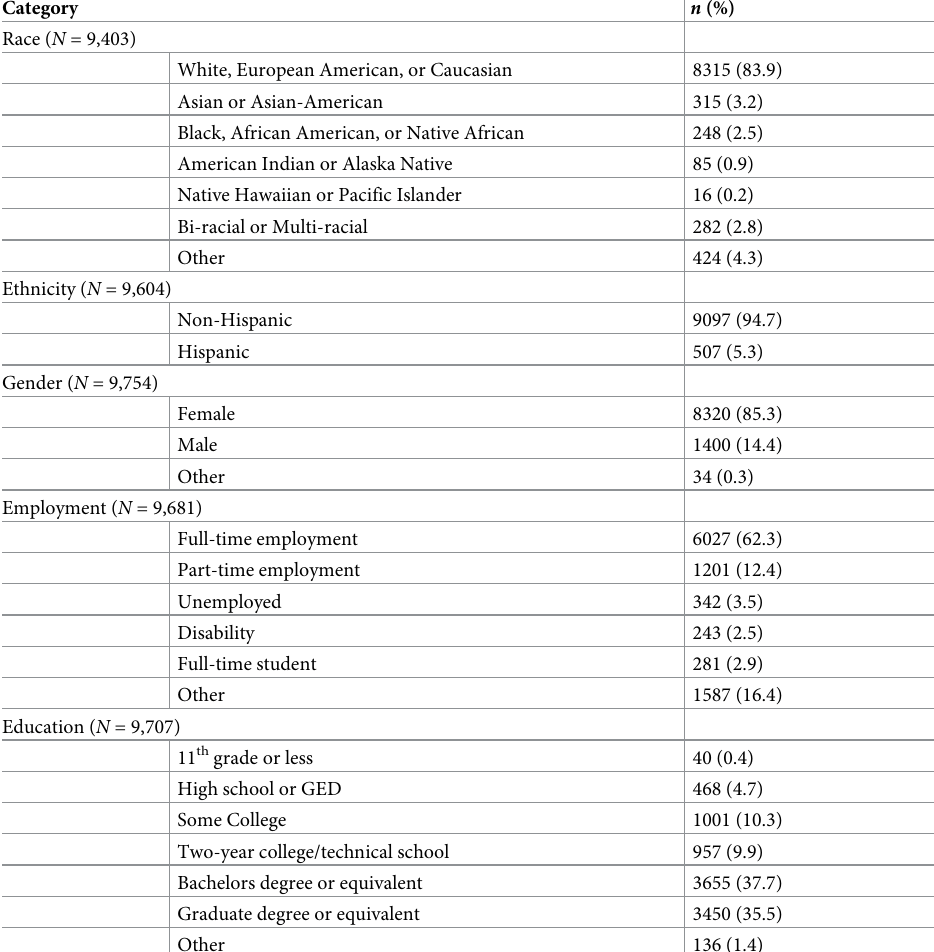
Table 1. Demographic characteristics of the sample (N =